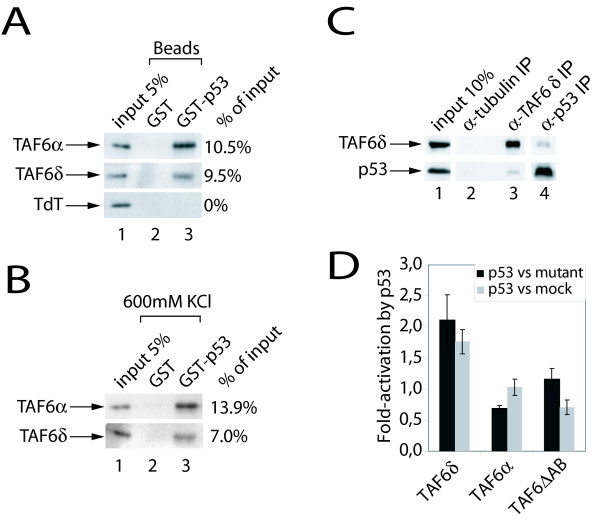
TAF6δ interacts physically and functionally with p53. (A) TAF6δ interacts with p53 in vitro. Recombinant purified TAF6α, TAF6δ, or TdT were incubated with immobilized GST-p53. Complexes were washed and retained proteins were analyzed by Western blot. The percentage of retention as quantified by phosphoimager analysis is given at the right. (B) Complexes were washed as in (A) except that the washing buffer contained 600 mM KCl. (C) TAF6δ interacts with p53 in vivo. HCT116 p53 -/- cells were transfected with plasmids expressing TAF6δ and p53. 28 hours post-transfection protein interactions were assayed by co-immunoprecipitation followed by Western blotting with the appropriate antibodies (Materials and Methods). (D) TAF6δ enhances p53-mediated activation of the DUSP1 promoter. HeLa cells were co-transfected with a plasmid expressing the firefly luciferase gene under control of DUSP1 promoter, a plasmid expressing p53 or its mutant R175H or no p53 and various constructs of TAF6. 28 h after transfection, cells were lysed and luciferase activity was measured. Shown are the ratios of relative light unit (RLU) given by cells transfected with p53 relative to cells transfected with p53R175H (black bars) or no p53 (grey bars).